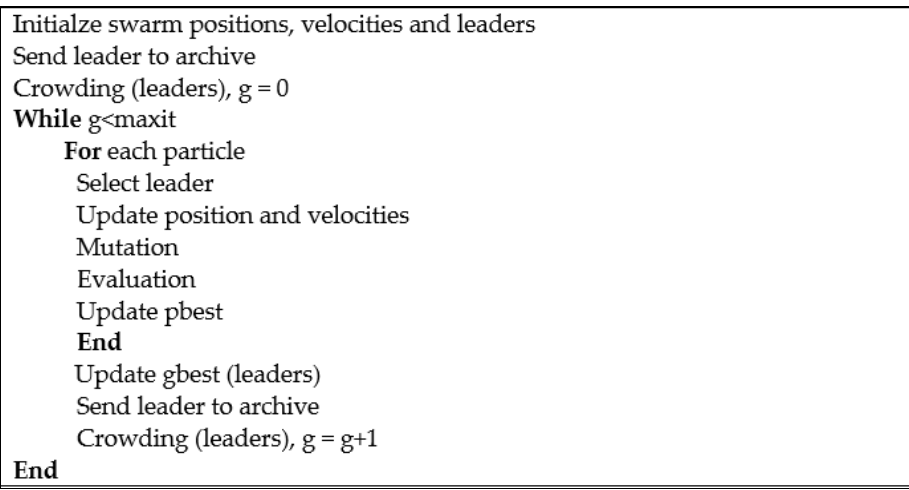
Figure 4. Pseudocode of MOPSO.